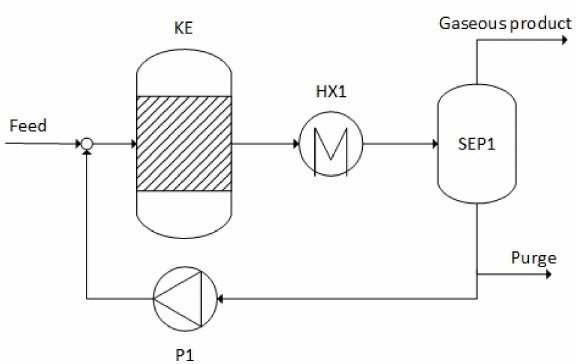
Figure 3. Process flow diagram for the production of ethane via Kolbe electrolysis (KE: Kolbe electrolysis, HX1: heat exchanger, SEP1: liquid–gas separation, P1: